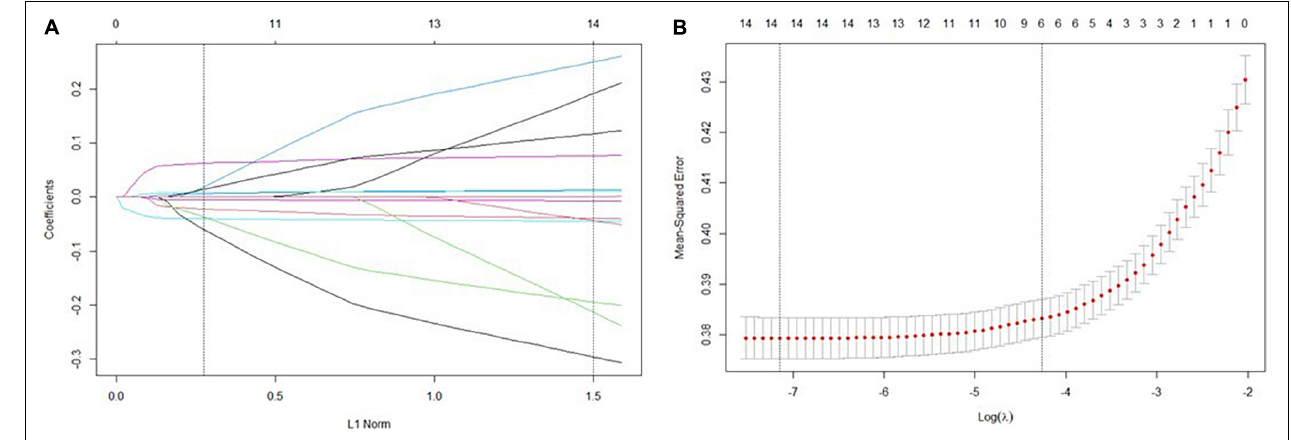
FIGURE 1 | Predictor selection using the least absolute shrinkage and selection operator (LASSO) binary logistic regression model. (A) Identification of the optimal penalization coefficient lambda ( λ ) in the Lasso model used tenfold cross-validation and the minimum criterion. (B) Lasso coefficient profiles of the features. Vertical line was drawn at the value selected using tenfold cross-validation, where optimal values by using the minimum criteria and the 1 standard error of the minimum criteria (the 1-se criteria).